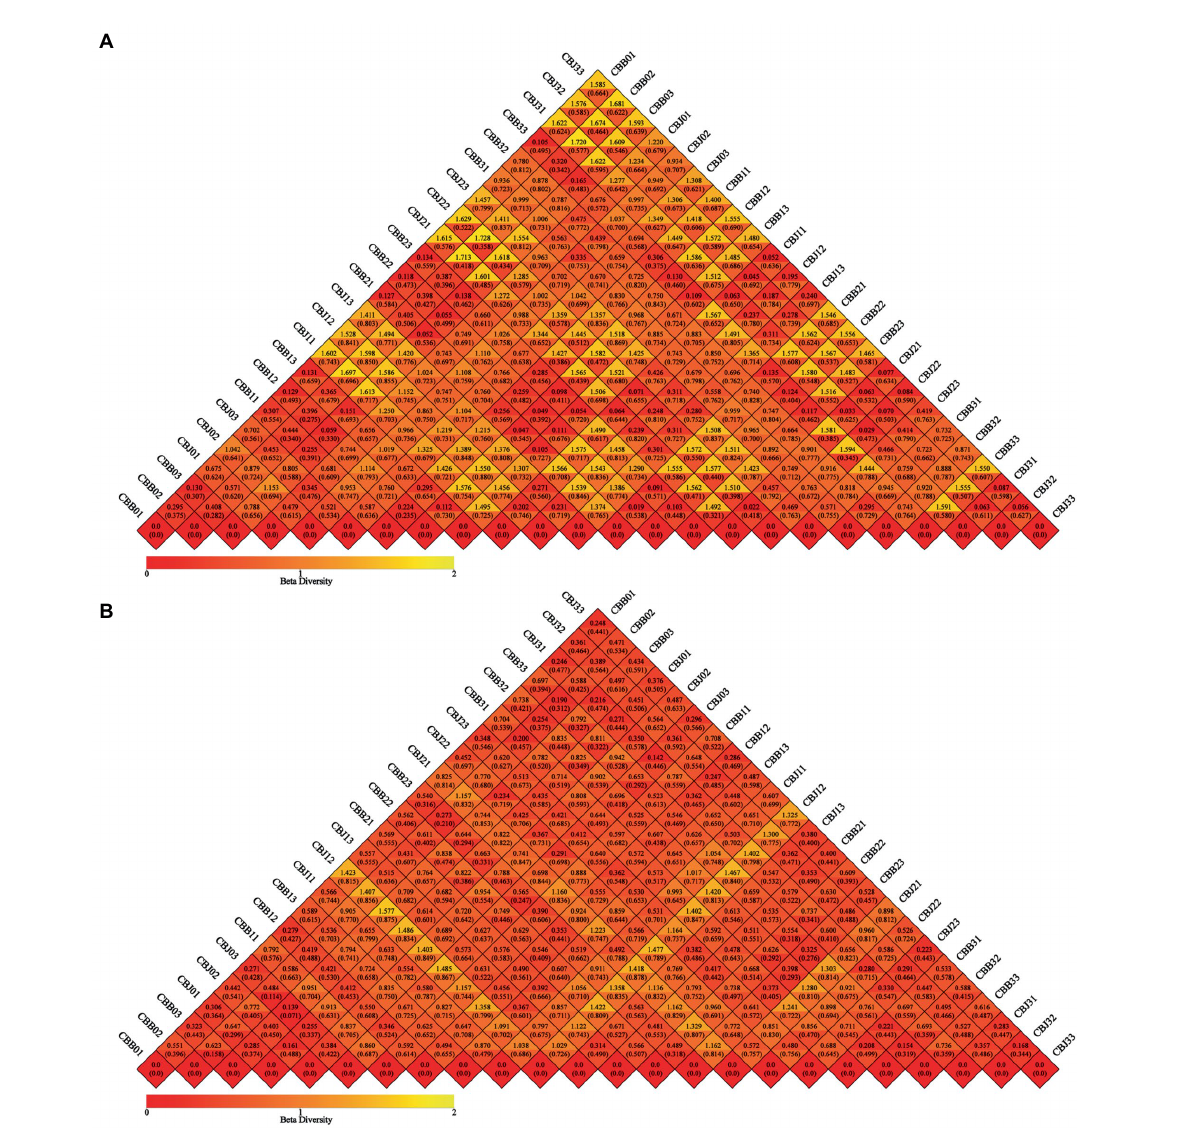
FIGURE 5 Beta diversity heatmap diagram of microbial communities in tobacco leaves (symptomatic leaves CBB; asymptomatic leaves CBJ) at four sampling time points (The first numbers 0–3 in the sample name represent four different sampling time points, respectively. The numbers 1–3 at the end of the sample name represent three biological replicates.). (A) For fungal communities, (B) for bacterial communities. In the same grid, the upper and lower values represented Weighted Unifrac and Unweighted Unifrac distance value,